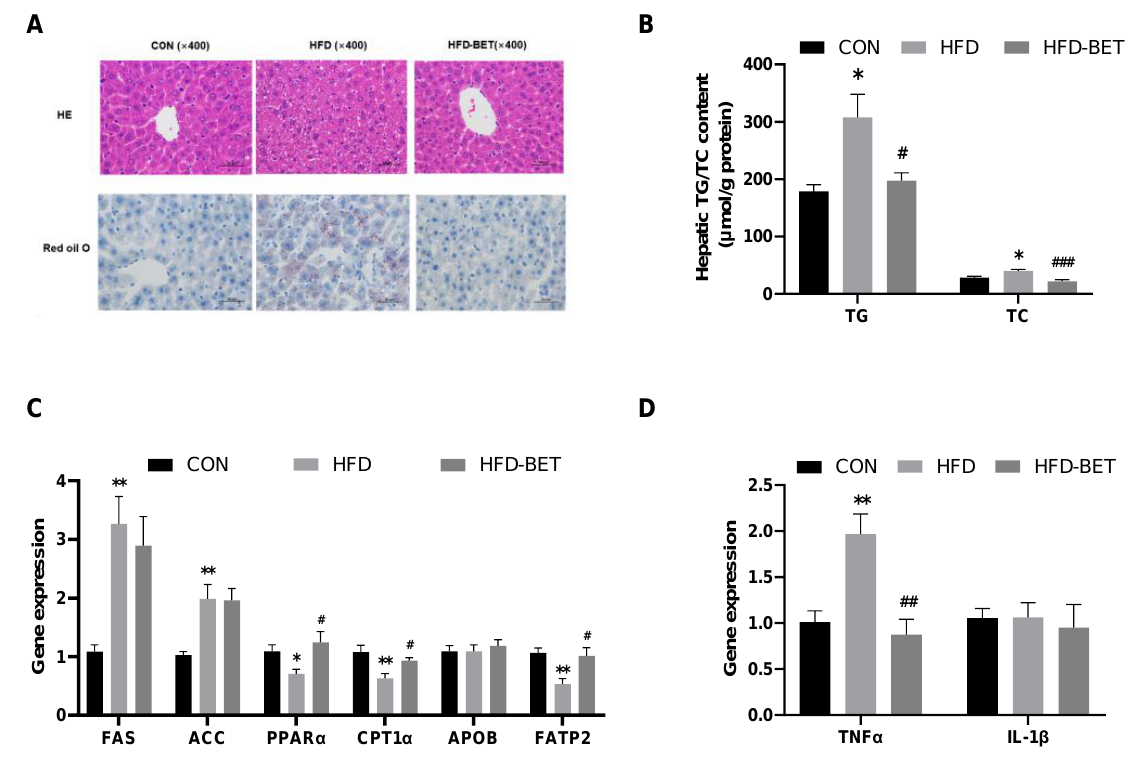
Figure 2. Maternal betaine supplementation attenuated NAFLD in offspring mice under MHFD. ( A ) Hematoxylin–eosin (H&E)- and oil red O-stained liver sections; ( B ) hepatic concentrations of TG and TC; ( C ) the mRNA expression of genes related to hepatic lipid metabolism; ( D ) the mRNA expression of genes related to hepatic inflammation. Data are presented as the means ± SEM. * p < 0.05 and ** p < 0.01 for the HFD group vs. the CON group; # p < 0.05, ## p < 0.01 and ### p < 0.001 for the HFD-BET group vs. the HFD group. Abbreviation: CON group, control diet group; HFD group, high-fat diet group; HFD-BET group, high-fat diet + 1% betaine group; TG, triglyceride; TC, total cholesterol.